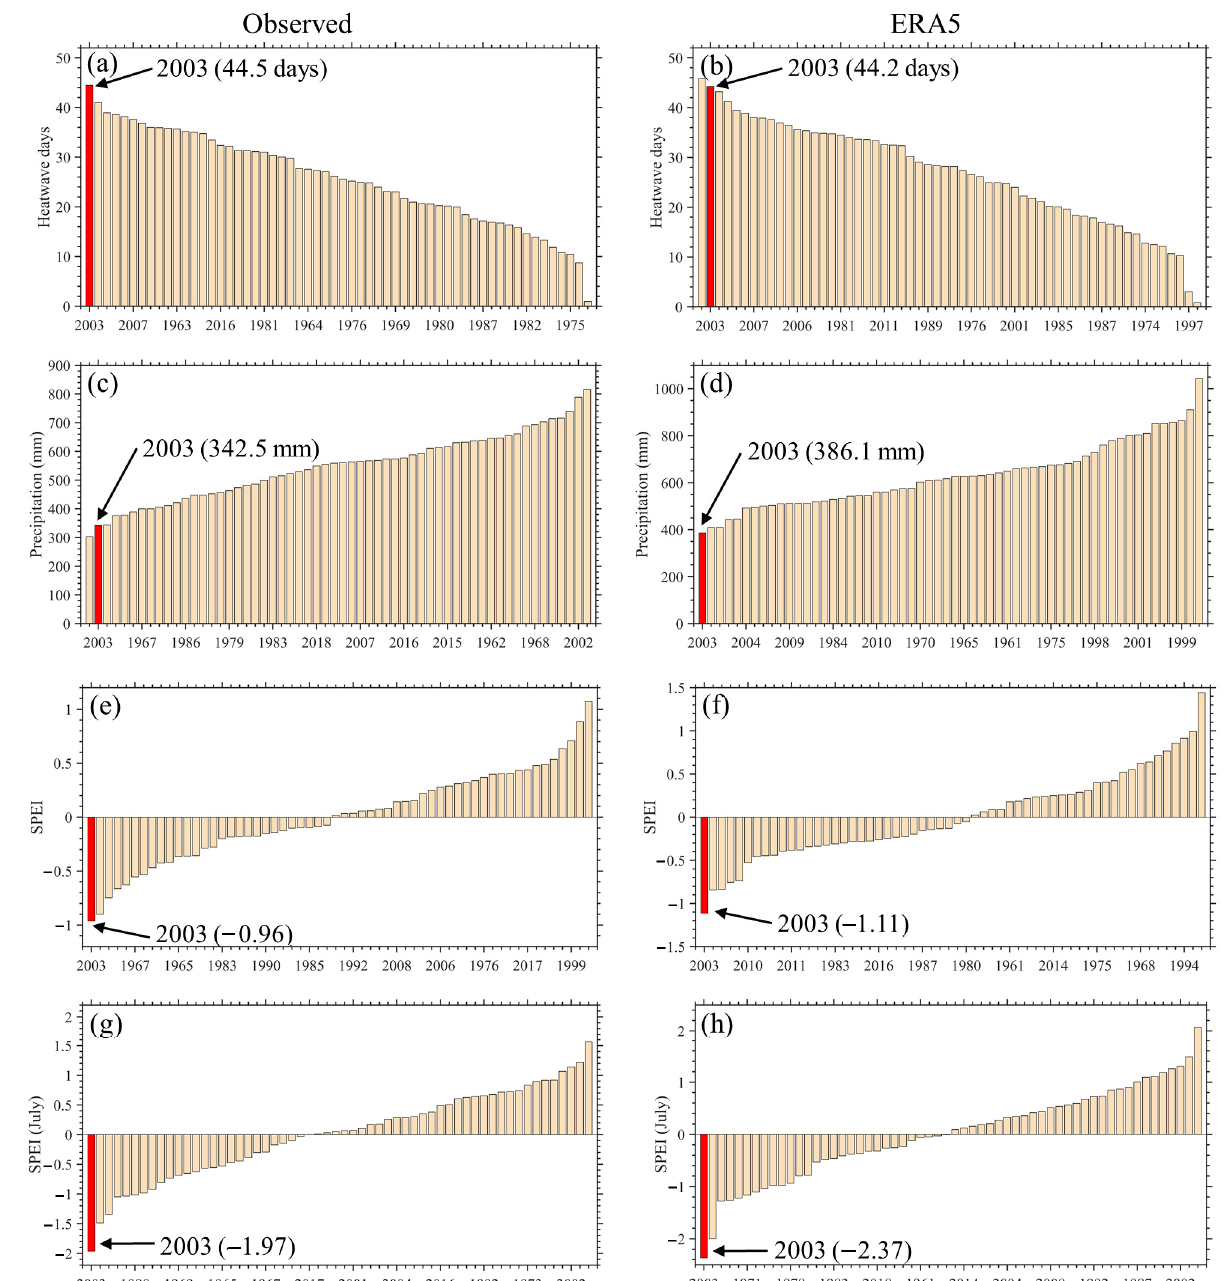
Figure 15. Rank-average during June–August of ( a , b ) heatwave days, ( c , d ) precipitation, ( e , f ) SPEI values, and ( g , h ) rank for the July SPEI values in the GRB from 1961 to 2018.